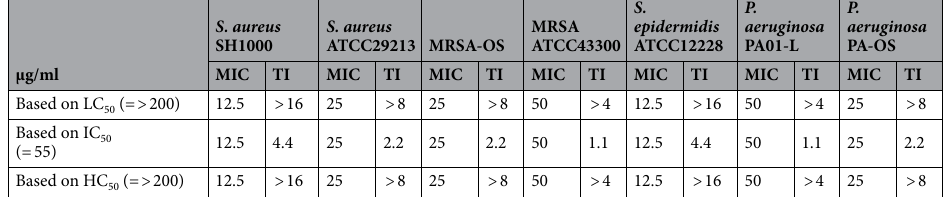
Table 4. Summary of therapeutic index of CaD23 determined based on cytotoxicity, cell viability, and hemolytic results. The minimum inhibitory concentration (MIC) values, based on the results in the presence of full-strength cationic Muller-Hinton broth (caMHB) without salt, and therapeutic index (TI) values are presented in mean values. MRSA: methicillin-resistant Staphylococcus aureus ; OS: ocular surface (clinical isolate); LC 50: concentration of treatment causing 50% cytotoxicity; IC 50 : concentration of treatment causing 50% inhibition of cell viability; HC 50 : concentration of treatment causing 50% hemolysis.